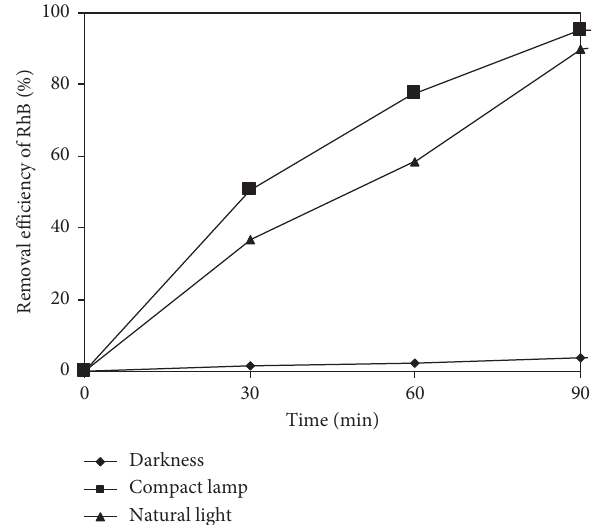
Figure 11: RhB degradation efficiency of C, N-TiO irradiation